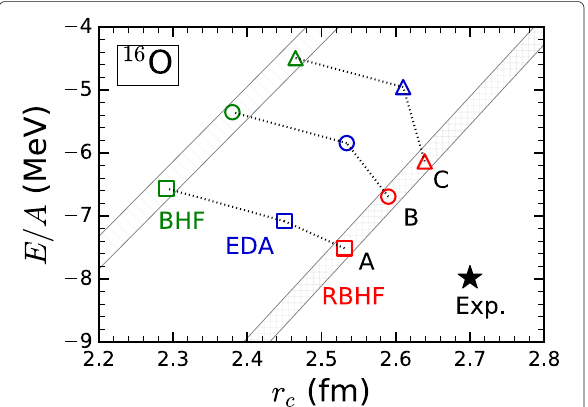
Fig. 6 Energy per nucleon E / A for 16 O as a function of the charge radius r c calculated by the relativistic Brueckner–Hartree–Fock (RBHF) using the interactions Bonn A, B, and C, in comparison with the results given by the Brueckner–Hartree–Fock (BHF) and the relativistic effective density approximation (EDA). Taken from Ref. [6] and RBHF, it reveals that the self-consistency is important to improve the description. Certain rearrangement effects brought by adopting renormalized occupation probabil- ities in RBHF may further improve the description for finite nuclei, especially for the